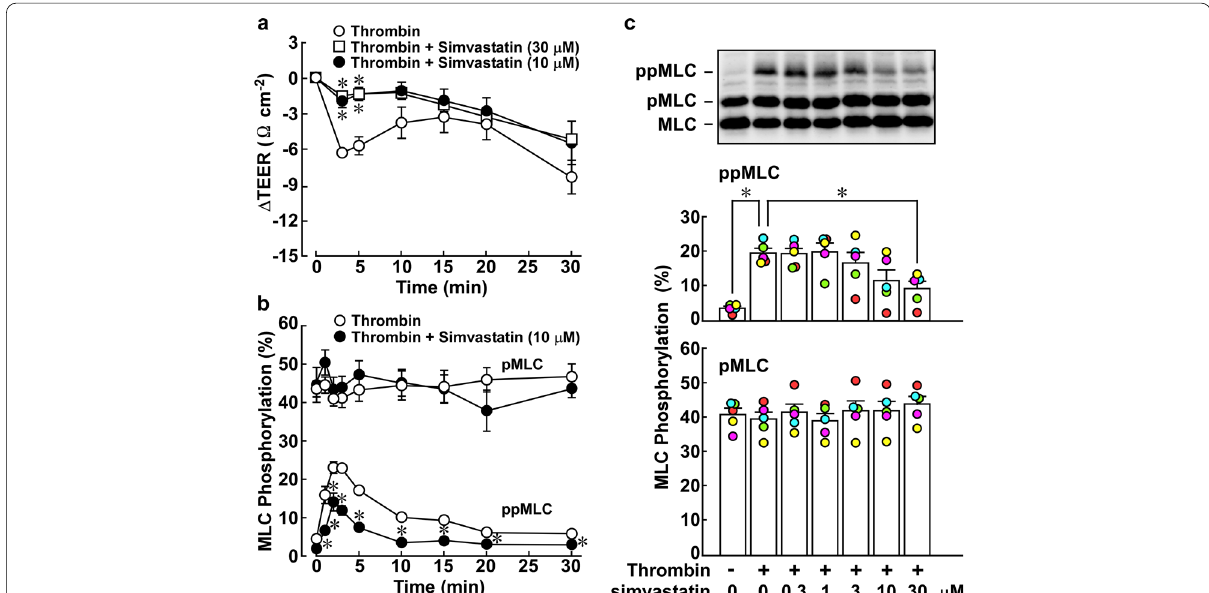
Fig. 1 Effects of simvastatin pretreatment on the thrombin-induced decrease in trans-endothelial electric resistance (TEER) and mono- and di-phosphorylation of myosin light chain (pMLC, ppMLC) in porcine aortic endothelial cells (PAECs). a , b The time courses of thrombin-induced changes in TEER (a, n 6), pMLC and ppMLC (b, n 4) are summarized. c A representative immunoblot and the summary for the = = concentration-dependent effects of simvastatin on pMLC and ppMLC at 3 min after thrombin stimulation are shown ( n were pretreated or left untreated with simvastatin at the indicated concentrations for 16 h. The cells were then stimulated with 1 unit/mL thrombin, in the presence of simvastatin, when pretreated. All original images of the immunoblot analyses are shown in Additional file 1: Figure S1. The data are expressed as the mean SEM. * P < 0.05 vs. thrombin, according to an ANOVA followed by Dunnett’s post hoc ±